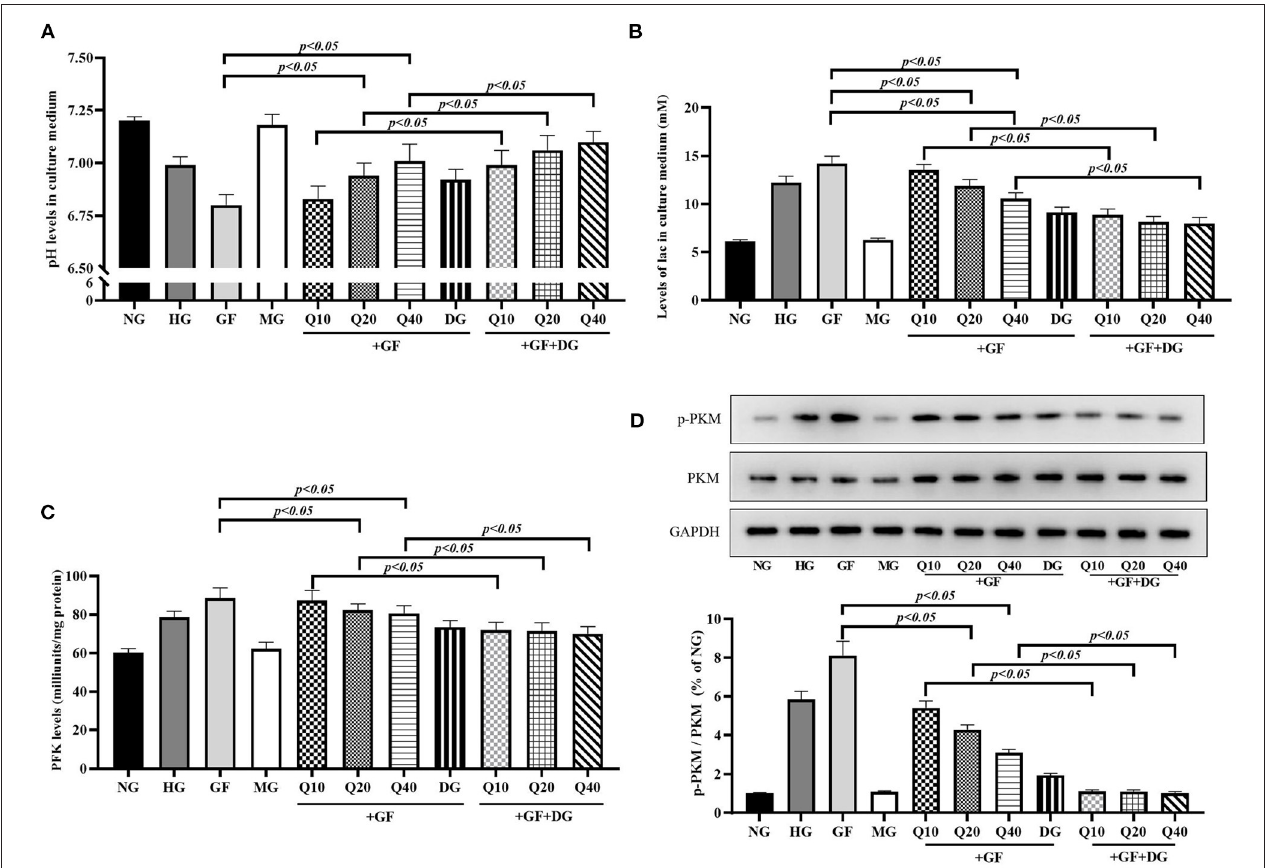
FIGURE 2 | Quercetin reversed GF-triggered aerobic glycolysis in glomerular MCs. (A) Levels of pH in each group. (B) Levels of lac in each group. (C) Activity of PFK tested by Colorimetric Assay. (D) Western blot analysis showing phosphorylation levels of PKM2 in each group. As expect, these GF-triggered increase of aerobic glycolysis could be dose-dependently blocked by quercetin and glycolytic pathway inhibitor 2-deoxyglucose (2-DG). The error bar reflects the S.E.M. of at least three independent